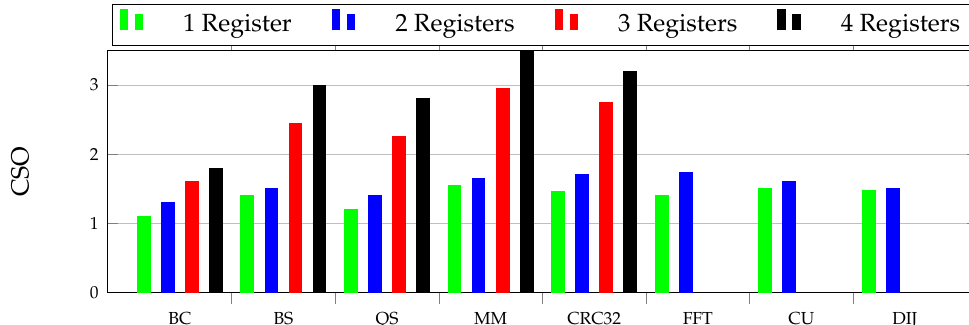
Figure 11. Measured code size for different case